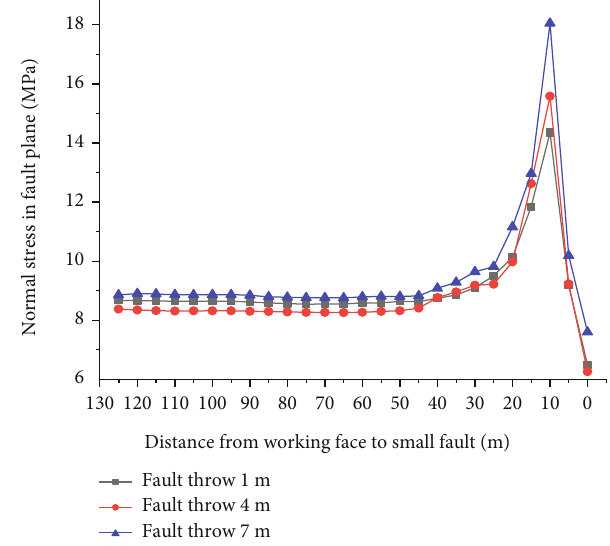
Figure 3: In fl uence of small fault drop on normal stress of fault plane. The black dotted line represents a fault throw of 1m, the red dotted line represents a fault throw of 4m, and the blue dotted line represents a fault throw of 7m.